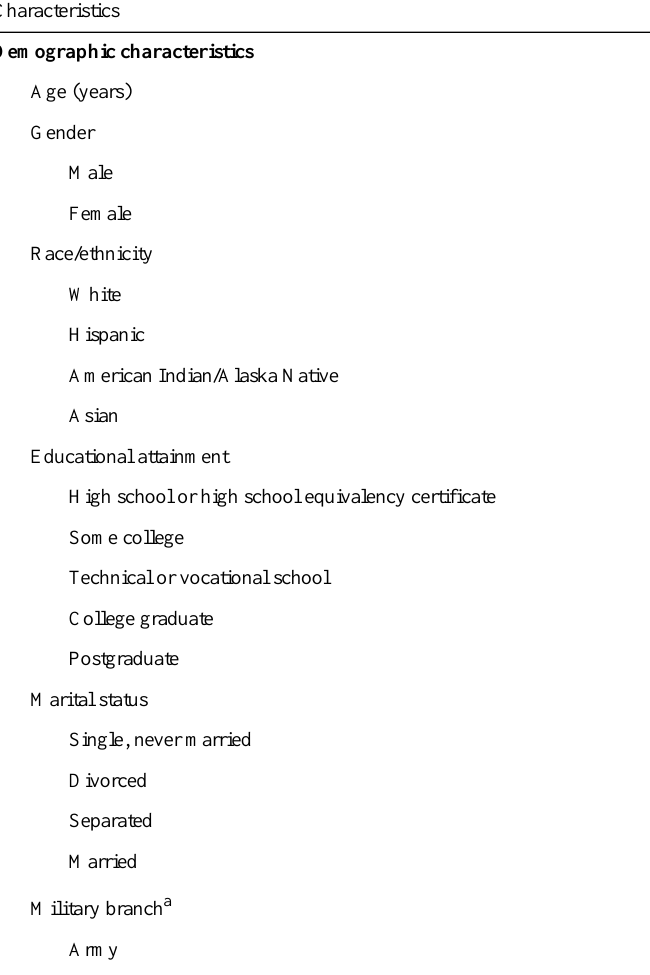
Table 1. Summary of participants’demographic, clinical, and social media use characteristics